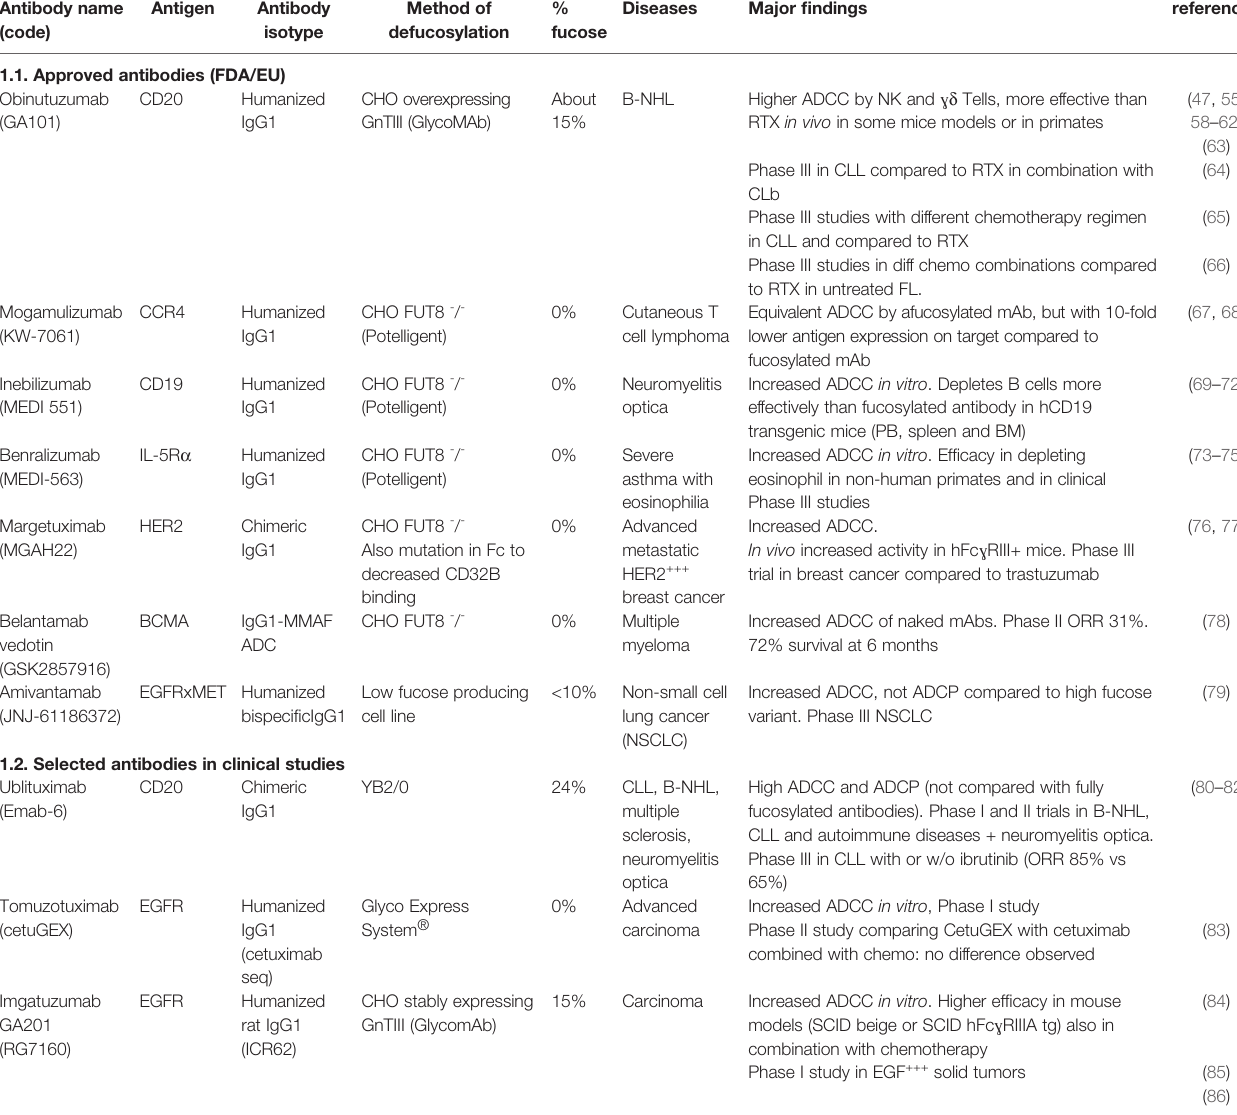
TABLE 2 | Selected therapeutic antibodies with low or no fucose, approved by FDA/EU or in clinical